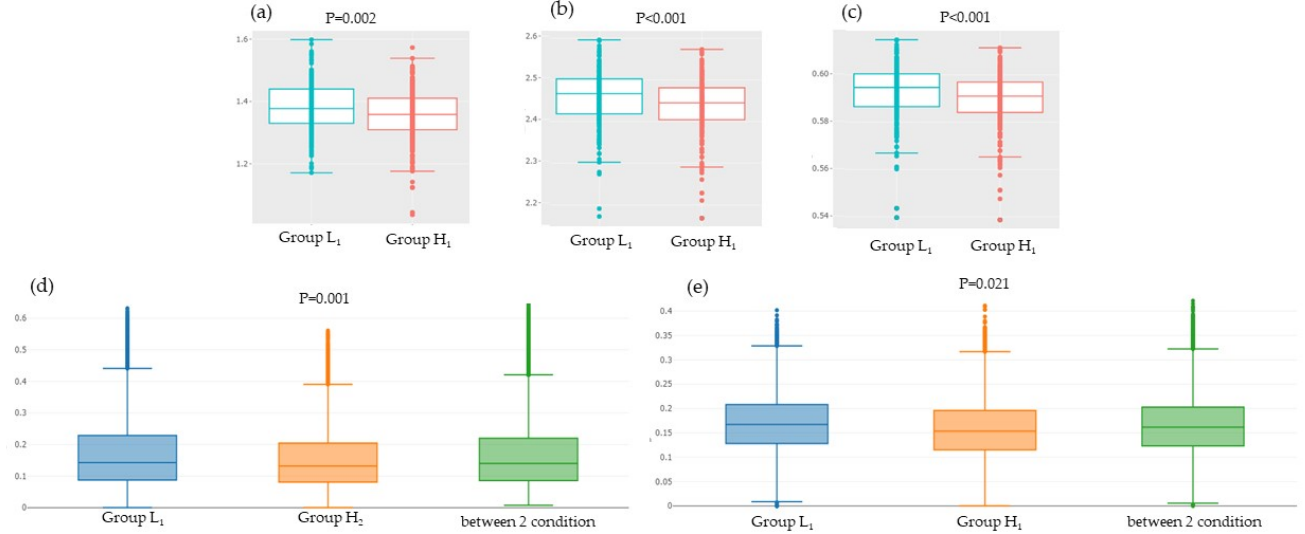
Figure 4. Comparison of the diversity of gut microbiota and water-soluble dietary fiber intake: ( a ) Shannon index; ( b ) Inverse Simpson; ( c ) Gini Simpson; ( d ) Weighted UniFrac distance; ( e ) Un- weighted UniFrac distance. Group L 1 : Water-soluble dietary fiber intake < 2.62 g/day in 2017; Group H 1 : Water-soluble dietary fiber intake ≥ 2.62 g/day in 2017.